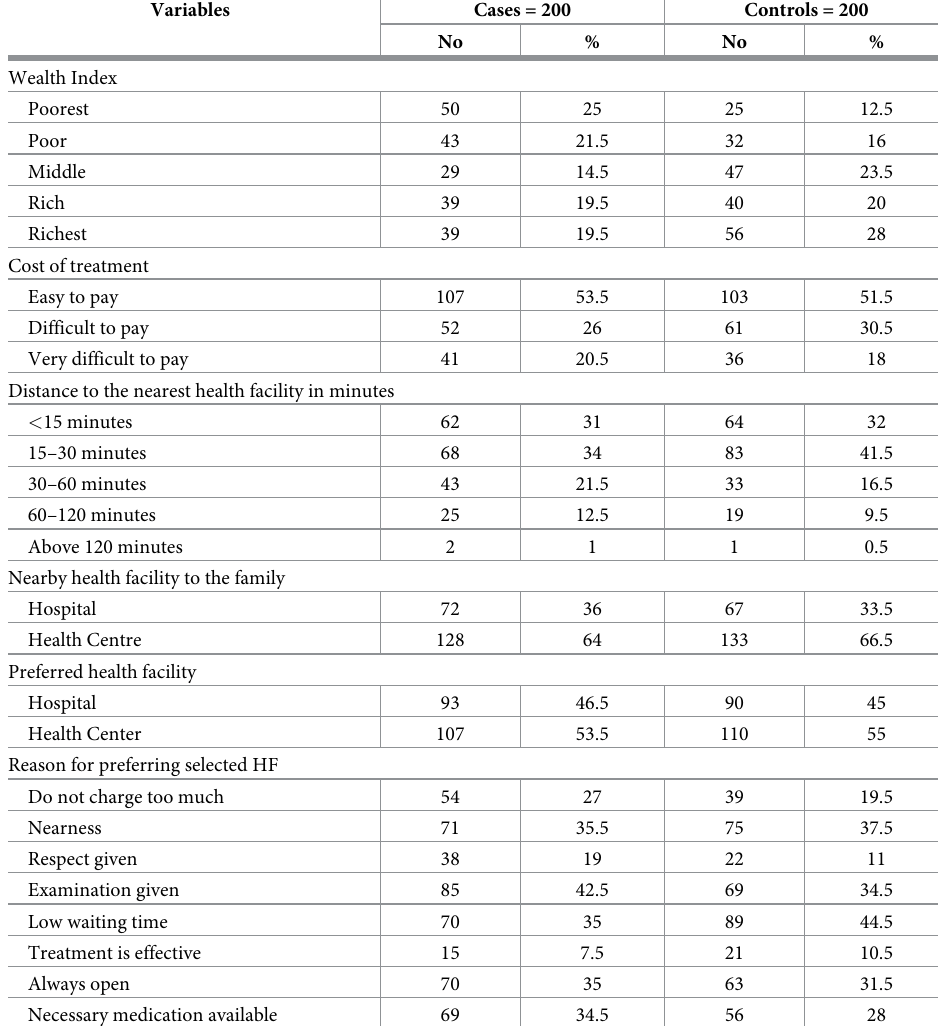
Table 2. Enabling factors of delay in seeking care among mothers/caregivers of < 5 children with diarrheal dis- eases in public health facilities of Arba Minch town, south Ethiopia, 2019(n =